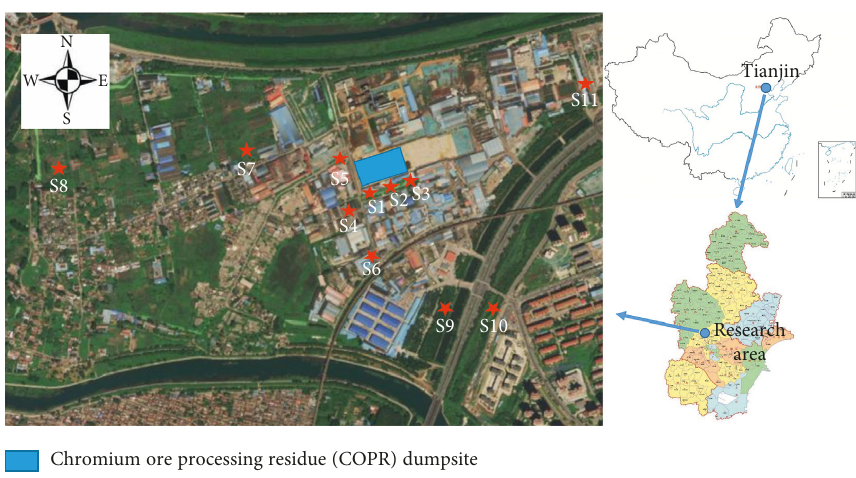
Figure 1: Schematic of sampling sites near the chromium ore processing residue (COPR)